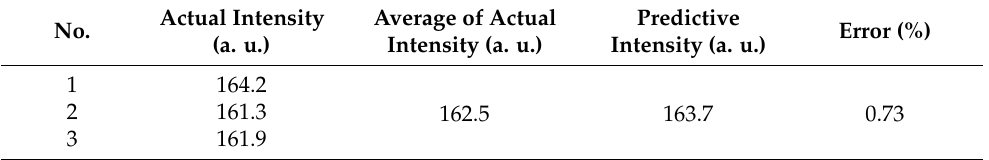
Table 6. Replication experiments of actual and predictive intensities of N-CQD preparation. Actual Intensity Average of Actual No. (a. u.) Intensity (a. u.)